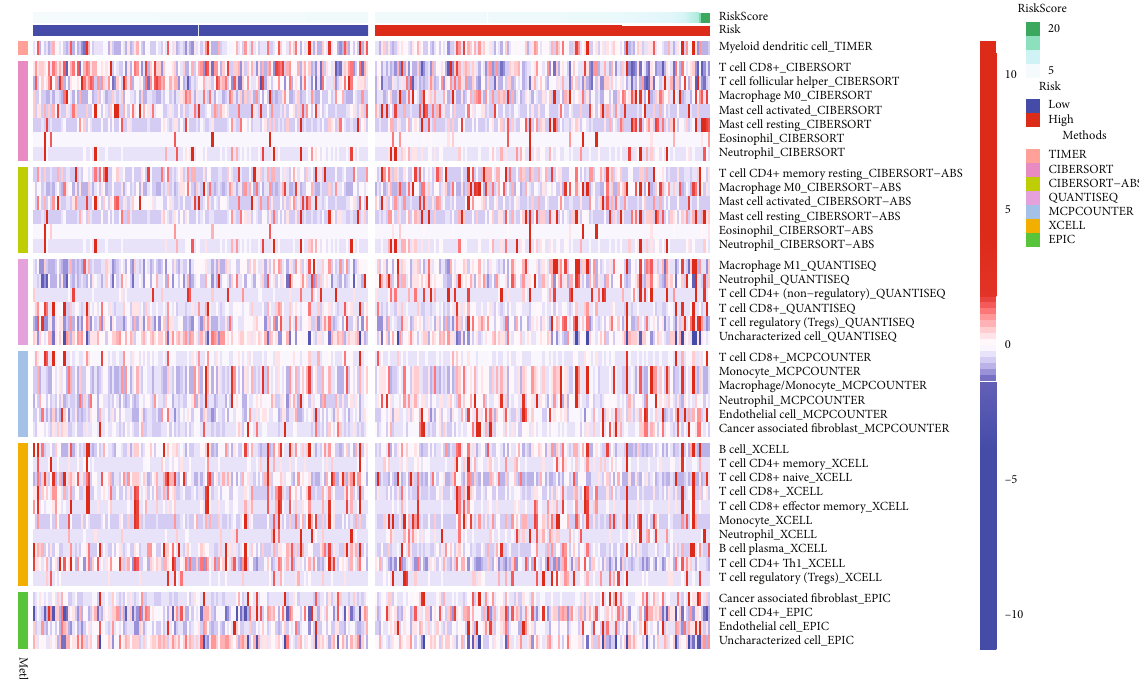
Figure 6: Heat map for immune responses by the use of TIMER, ssGSEA, MCPcounter, ESTIMATE, and CIBERSORT algorithms among low- and high-risk